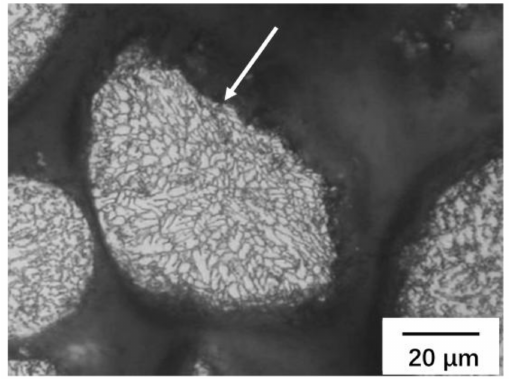
Figure 3. Morphology of a particle after the